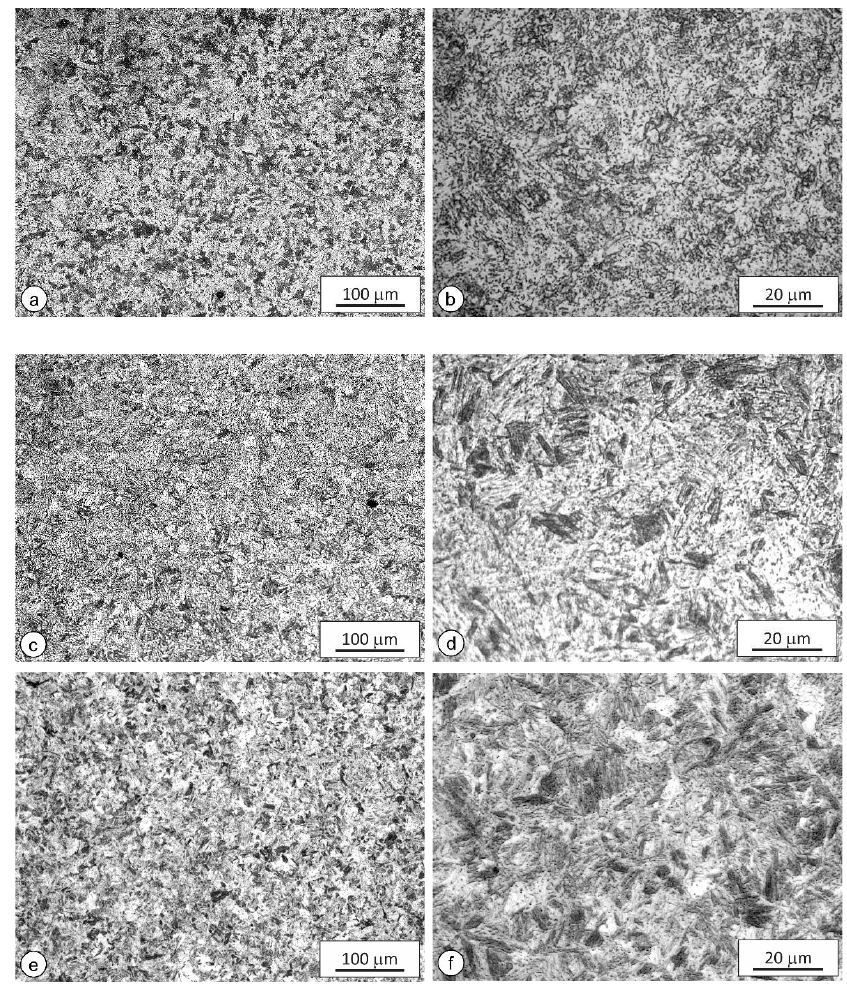
Figure 6. Microstructure of FG HAZs: ( a ) real-weld FG HAZ, 200×; ( b ) real-weld FG HAZ, 1000×; ( c ) WTCS specimen, 200×; ( d ) WTCS specimen, 1000×; ( e ) AF + WQ specimen, 200×; ( f ) AF + WQ ( c ) WTCS specimen, 200 × ; ( d ) WTCS specimen, 1000 × ; ( e ) AF + WQ specimen, 200 × ; ( f ) AF + WQ specimen, 1000×. specimen, 1000 ×